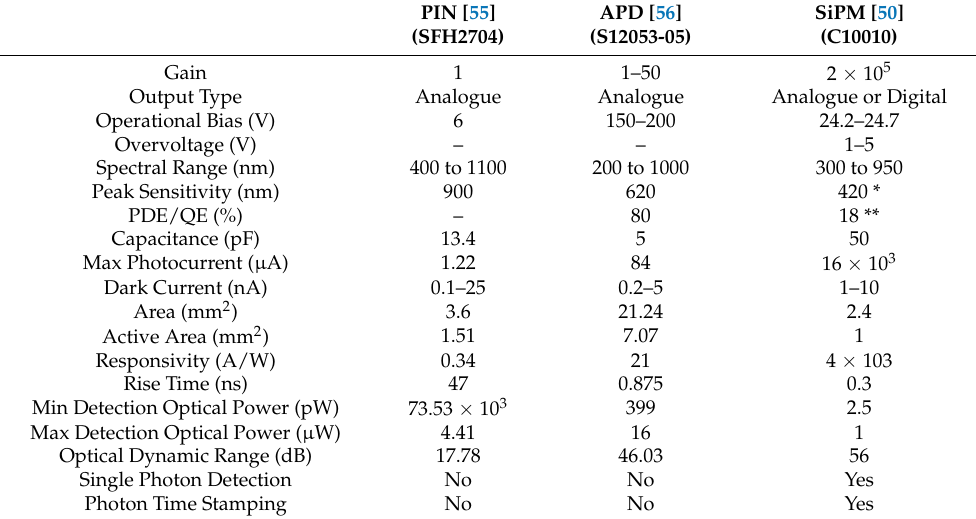
Table 3. Performance comparison of the PIN diode, APD and